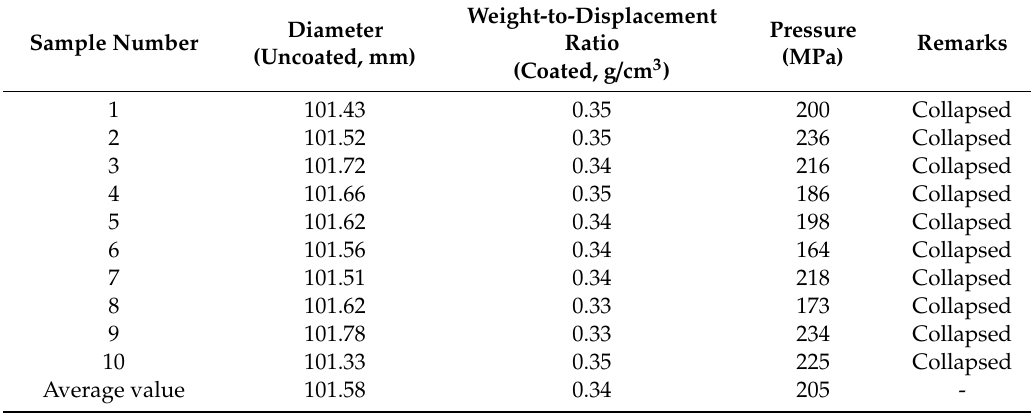
Table 3. Results of sustained and cyclic hydrostatic pressure tests.